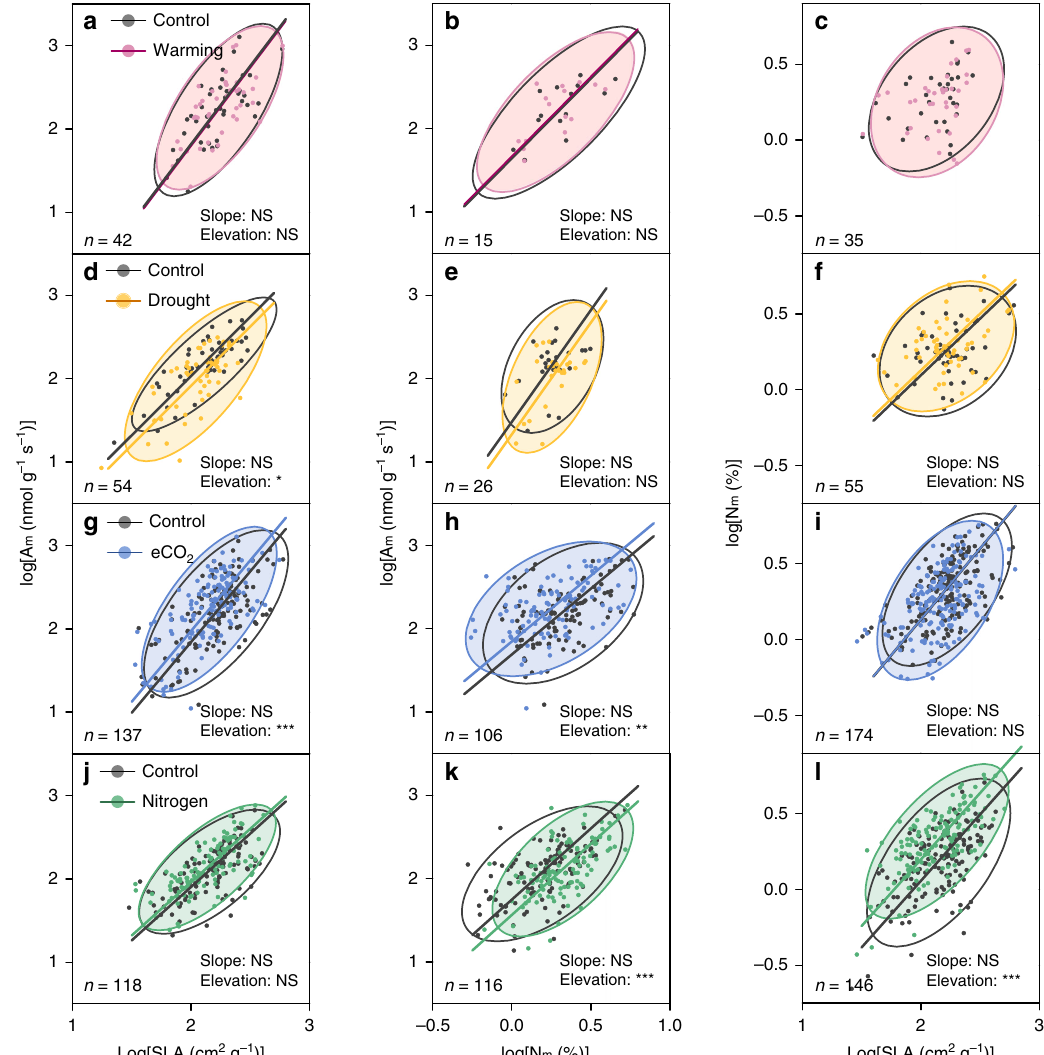
Fig. 4 Robustness of leaf trait relationships under different global environmental changes. The panels show the effects of warming ( a – c ), drought ( d – f ), eCO 2 ( g – i ) and nitrogen addition ( j – l ), respectively. The bold lines represent SMA regressions of leaf trait relationships. The ellipses show the 95% con fi dence level of the original scatter. The homogeneity among SMA slopes via a permutation test and for differences in SMA elevation via the SMA analog of standard ANCOVA. The statistics information is shown in Supplementary Table 3. The number of species under treatments of warming, drought, eCO 2 , and nitrogen addition are 42, 54, 137, and 118 for A m – SLA, 15, 26, 106, and 116 for N m – SLA, and 35, 55, 174, and 146 for N m – SLA (i.e., the numbers shown near the ellipses). The Signi fi cance of changes in slopes and elevations: NS: P > 0.05; * P < 0.05; ** P < 0.01; *** P <